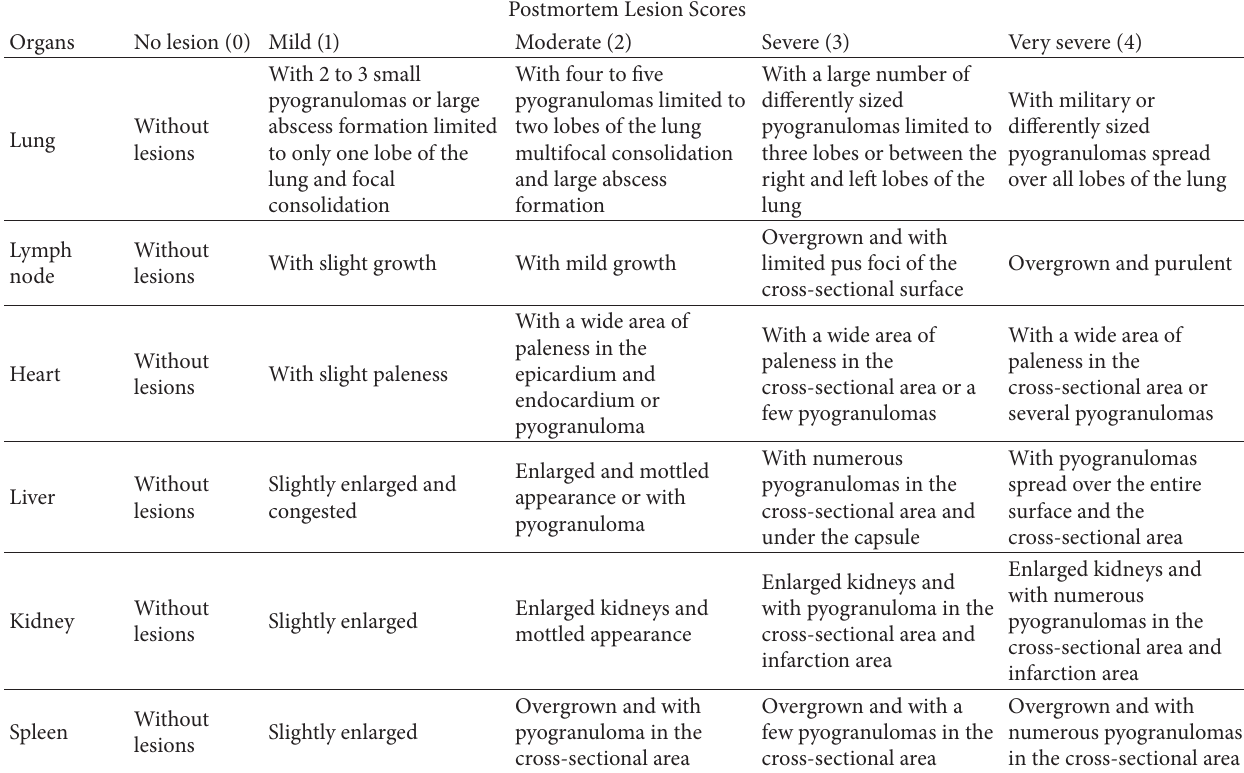
Table 1: Macroscopic lesions scores in lungs and organs after